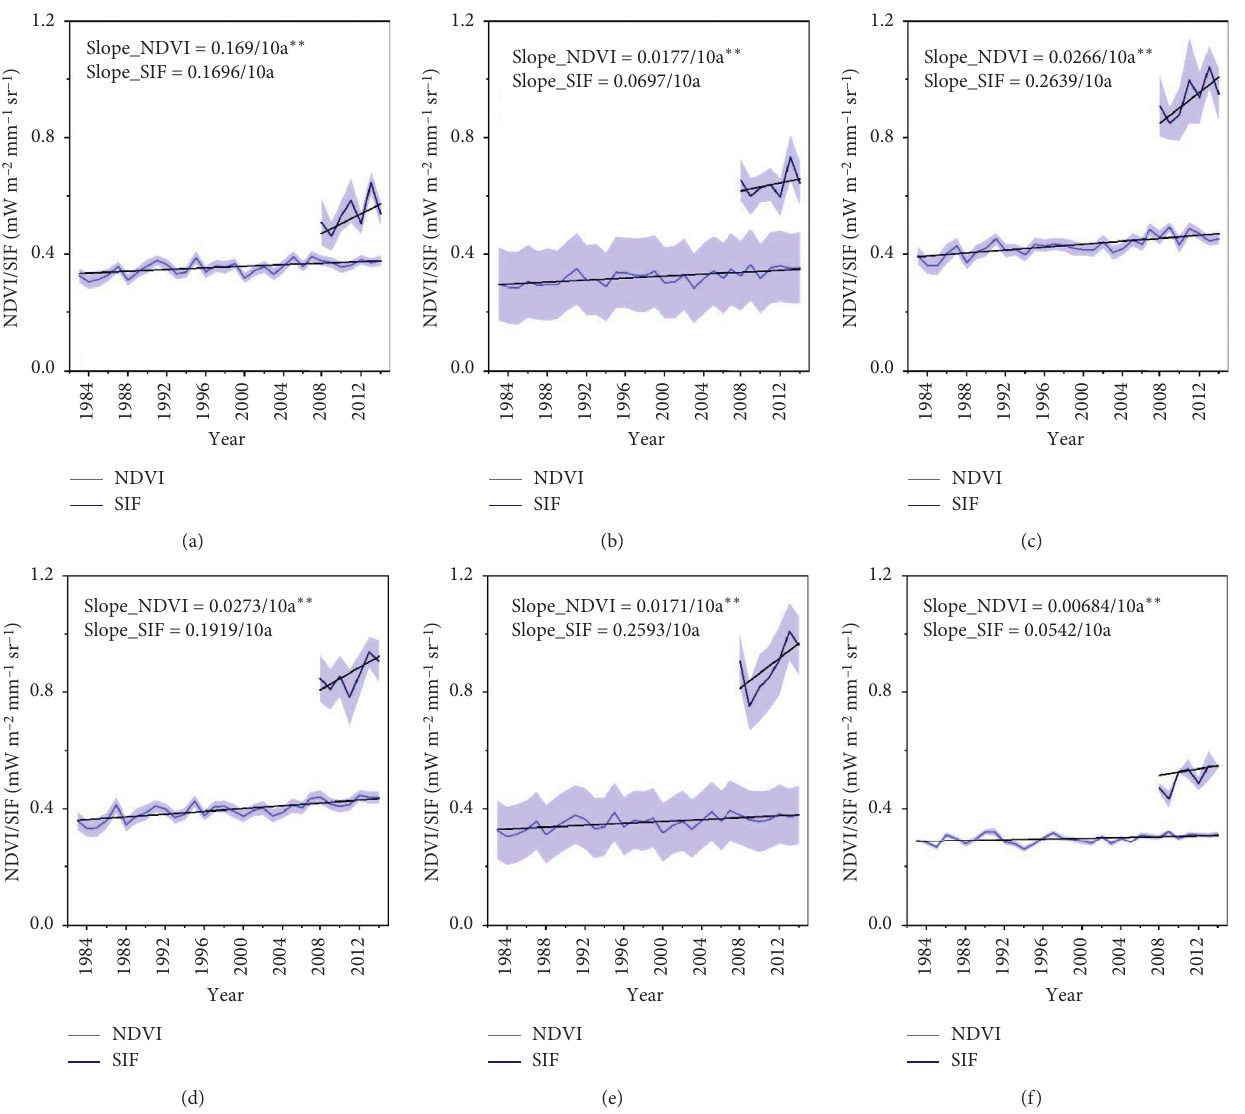
Figure 5: Linear trends of annual average NDVI (period: 1983–2014) and SIF (period: 2008–2014) in (a) Hebei, (b) Shandong, (c) Henan, (d) Anhui, (e) Jiangsu, and (f) Shanxi Provinces ( ∗∗ indicates P < 0 . 01; ∗ indicates P < 0 .